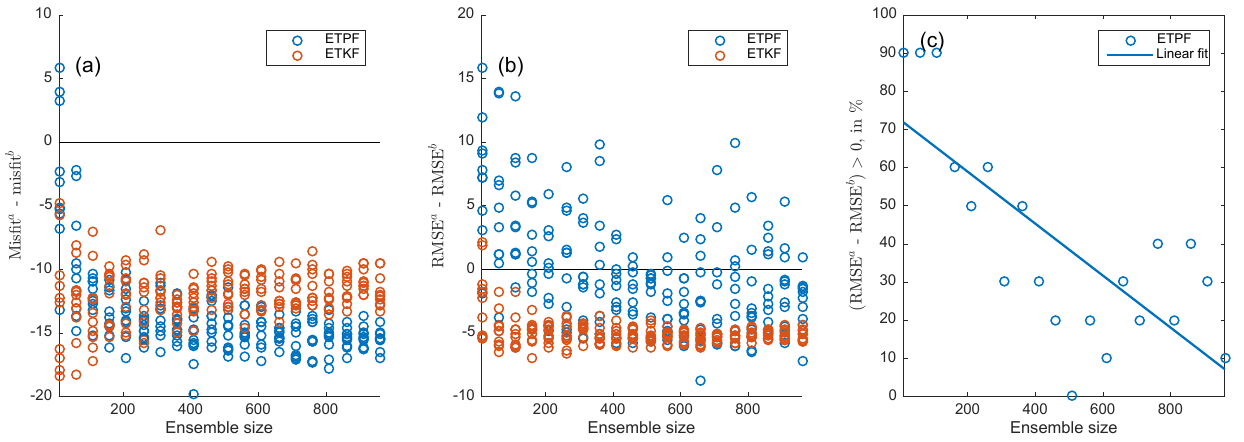
Figure 7. misfit a ,r − misfit b ,r (a) and RMSE a ,r − RMSE b ,r (b) w.r.t. ensemble size. ETPF is shown in blue, ETKF in red and zero level in black. One circle is for one simulation. For ETPF % of simulations that result in ( RMSE a − RMSE b ) > 0 and a linear fit as a function of ensemble size are shown in (c) .